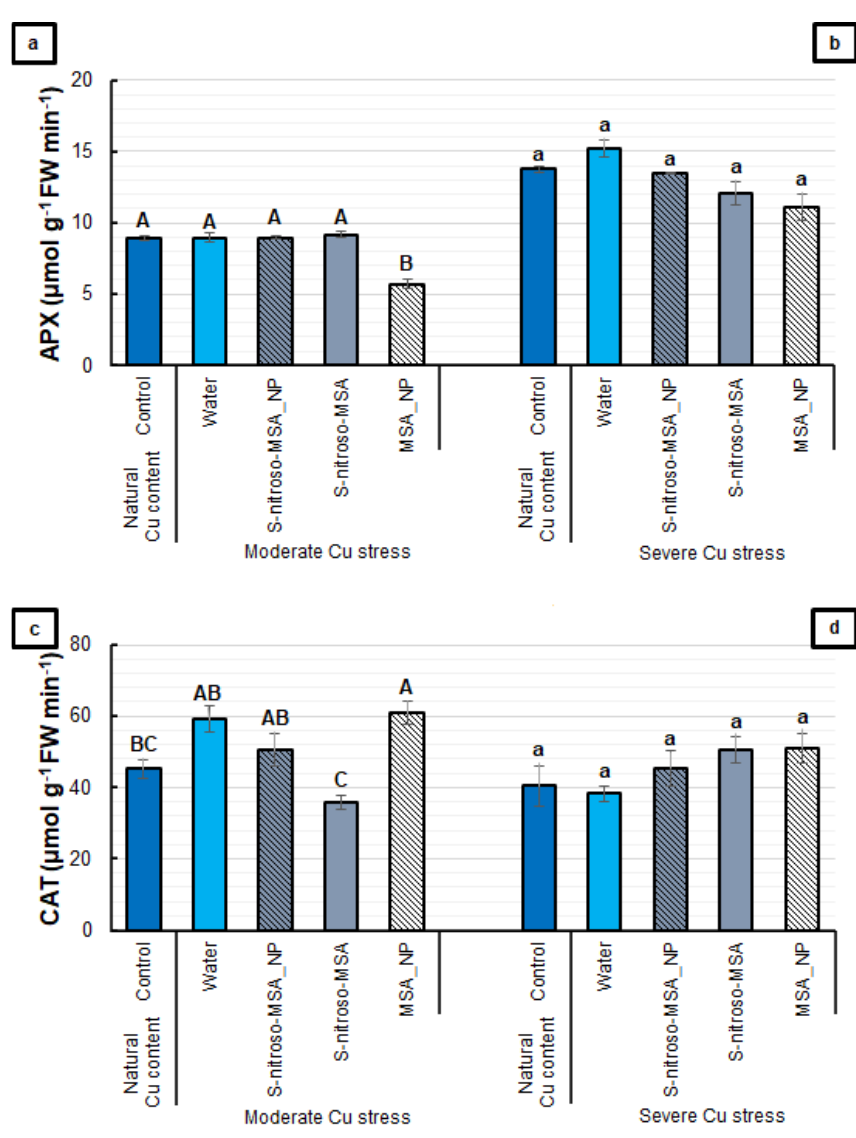
Figure 9. Root ascorbate peroxidase (APX) ( a , b ) and catalase (CAT) ( c , d ) activities of soybean plants cultivated in soil containing different copper (Cu) levels (natural content: 11 mg kg − 1 ; moderate Cu stress: 164 mg kg − 1 ; severe Cu stress: 244 mg kg − 1 ). Control = treatment with distilled water; water = treatment with distilled water after Cu addition; S-nitroso-MSA_NP = treatment with a nanoencapsulated NO donor (S-nitroso-mercaptosuccinic acid) at 1 mM; S-nitroso-MSA = treatment with a NO donor (S-nitroso-mercaptosuccinic acid) in the free form at 1 mM; MSA_NP = treatment with nanoparticles containing the non-nitrosated MSA at 1 mM. Data are the mean ± standard error ( n = 4). The same uppercase and lowercase letters on the column (referring to experiments 1 and 2, respectively) indicate values that do not differ by ANOVA, followed by the Tukey test ( p < 0.05).